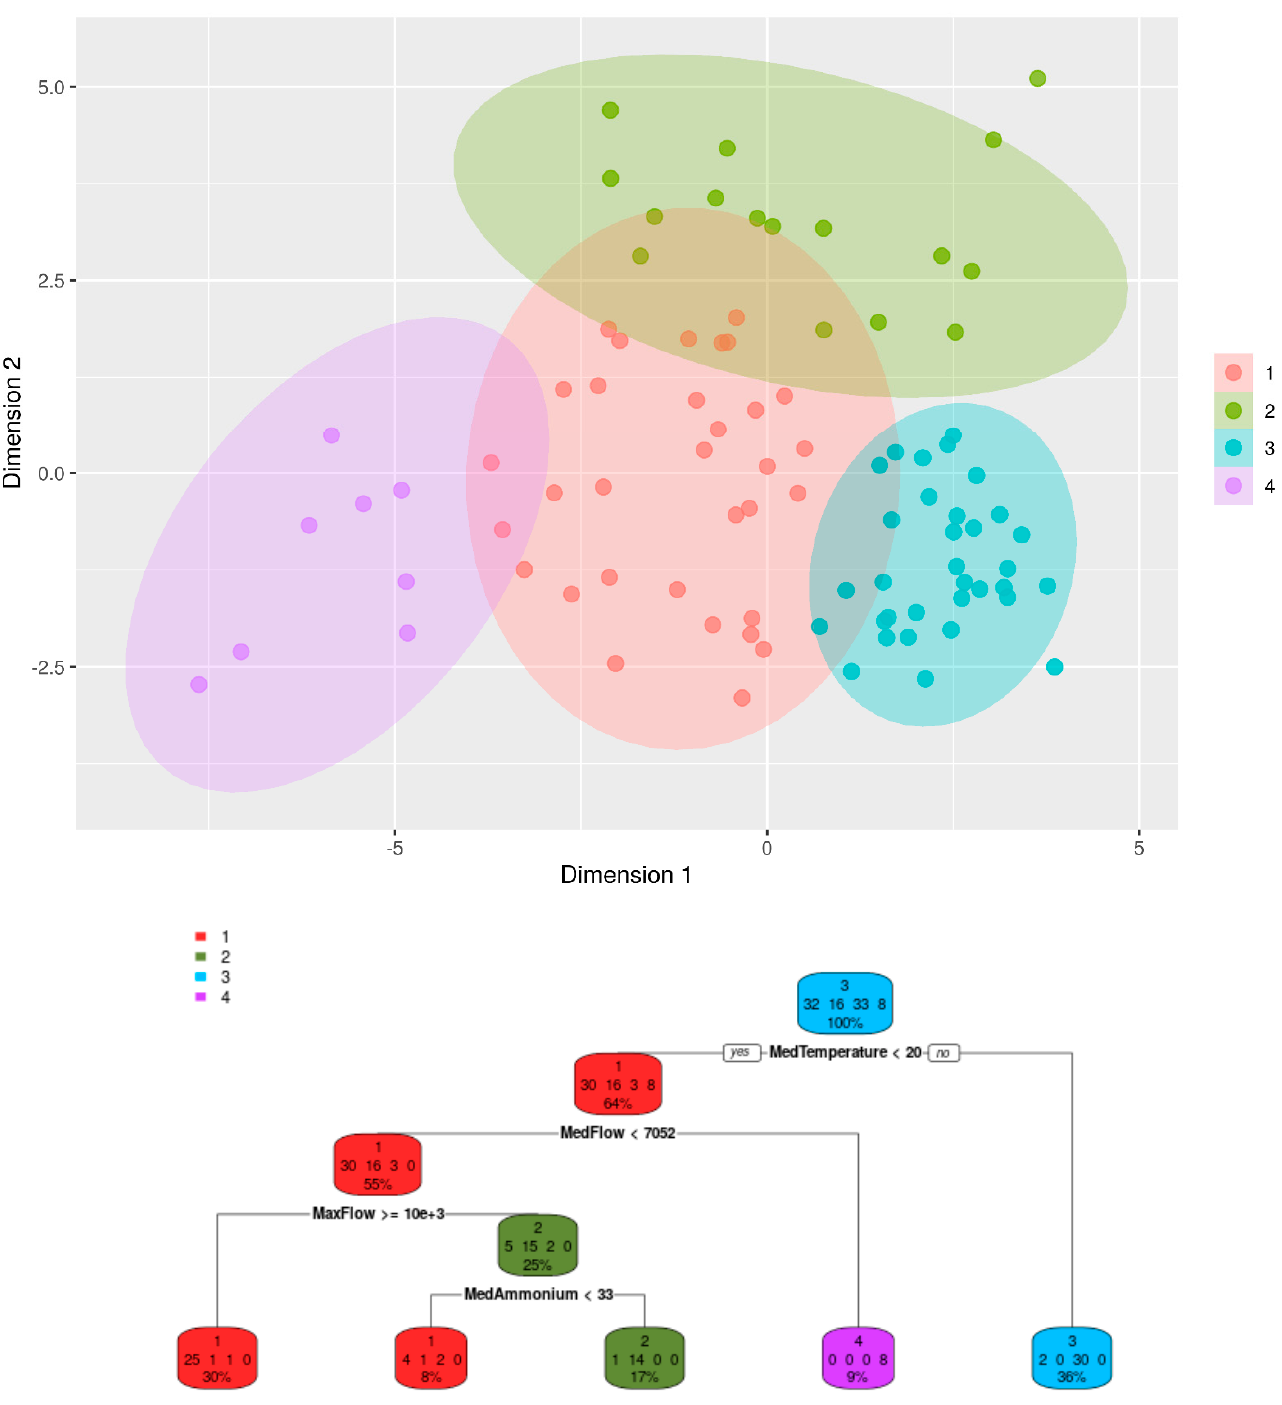
Figure 5. FOG Clusters of PCA projection.